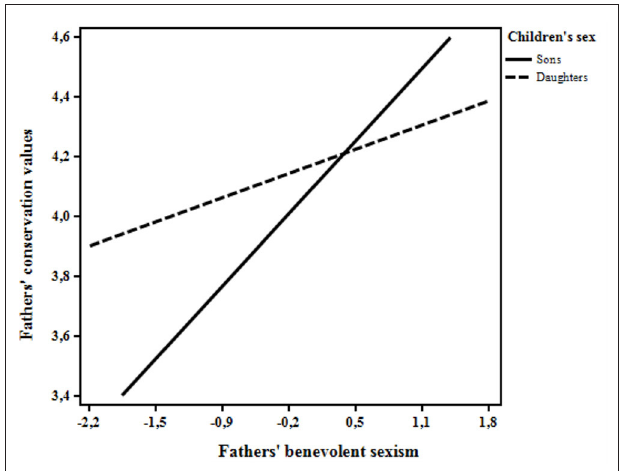
FIGURE 1 | The moderating role of children’s sex on the relation between fathers’ benevolent sexism and fathers’ conservation values.